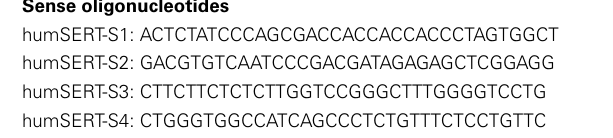
Table 2 | List of oligonucleotides used for in situ hybridization. HUMAN